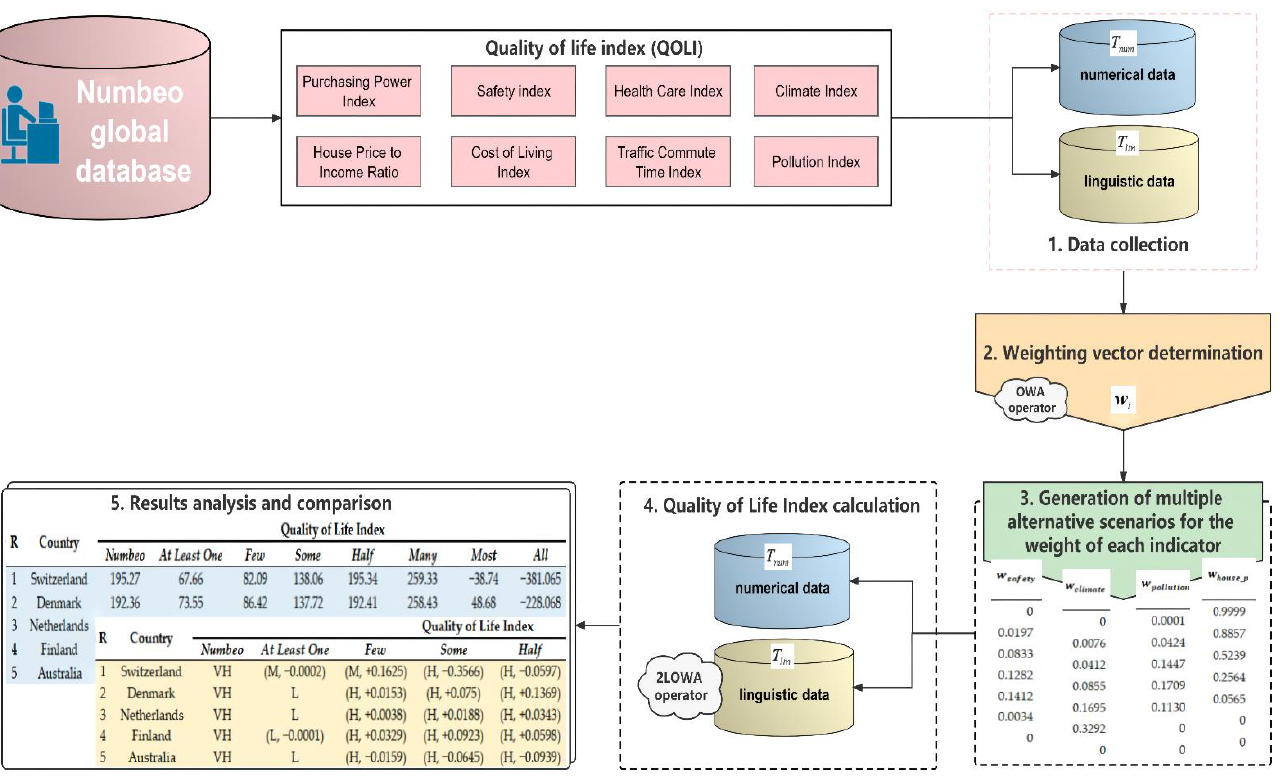
Figure 5. Example of quality of life data in Canada in the Numbeo database.